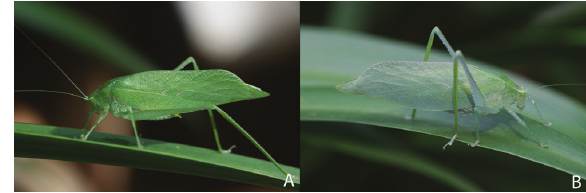
Figure 16. G. helleri sp. n., male ( A ) and female ( B ) from the Uluguru Mountains.